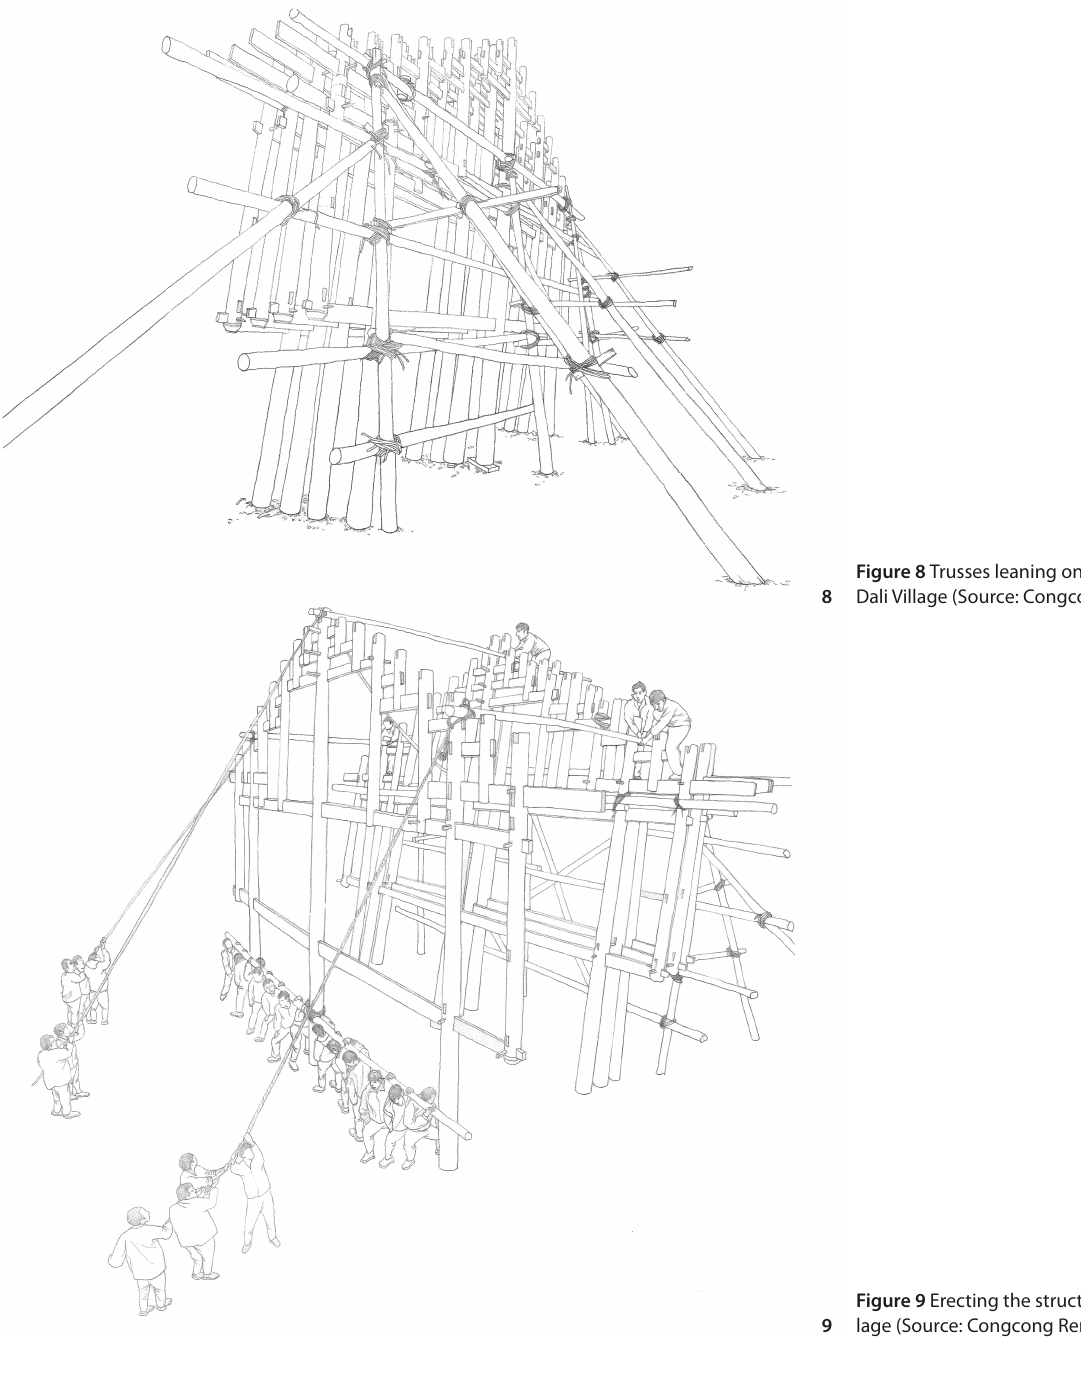
Figure 8 Trusses leaning on the supports, Dali Village (Source: Congcong